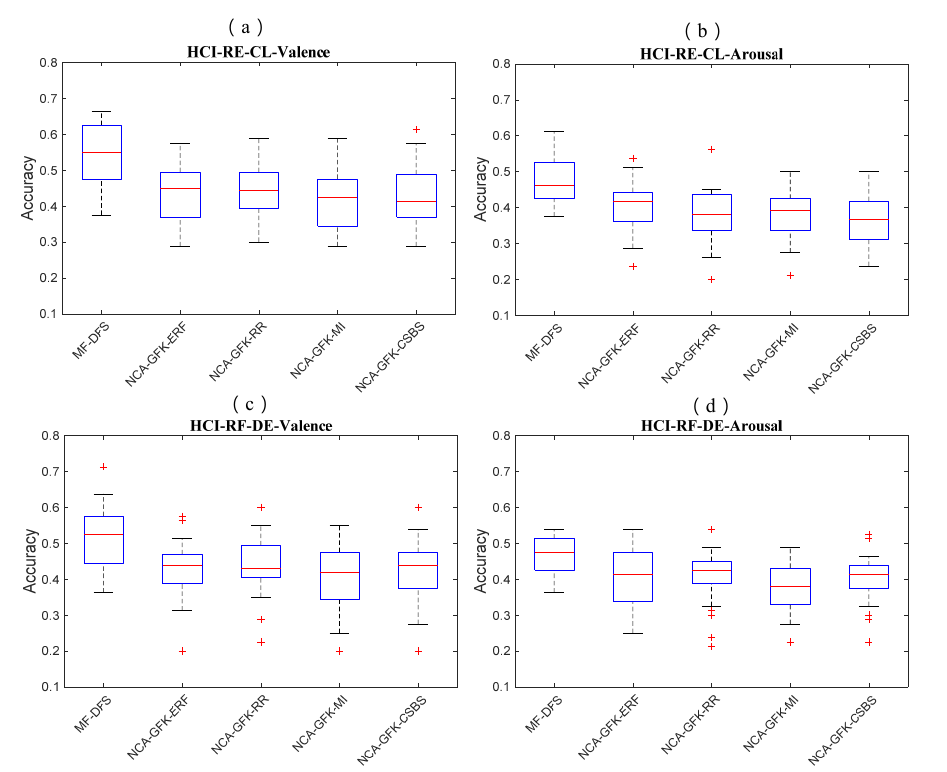
Figure 5. Boxplots of the classification accuracy based on the RF classifier combined with five feature selection methods of the MAHNOB-HCI database. The accuracies of CL features for the valence and arousal dimensions are shown in ( a , b ), respectively. The accuracies of DE features for the valence and arousal dimensions are shown in ( c , d ), respectively.